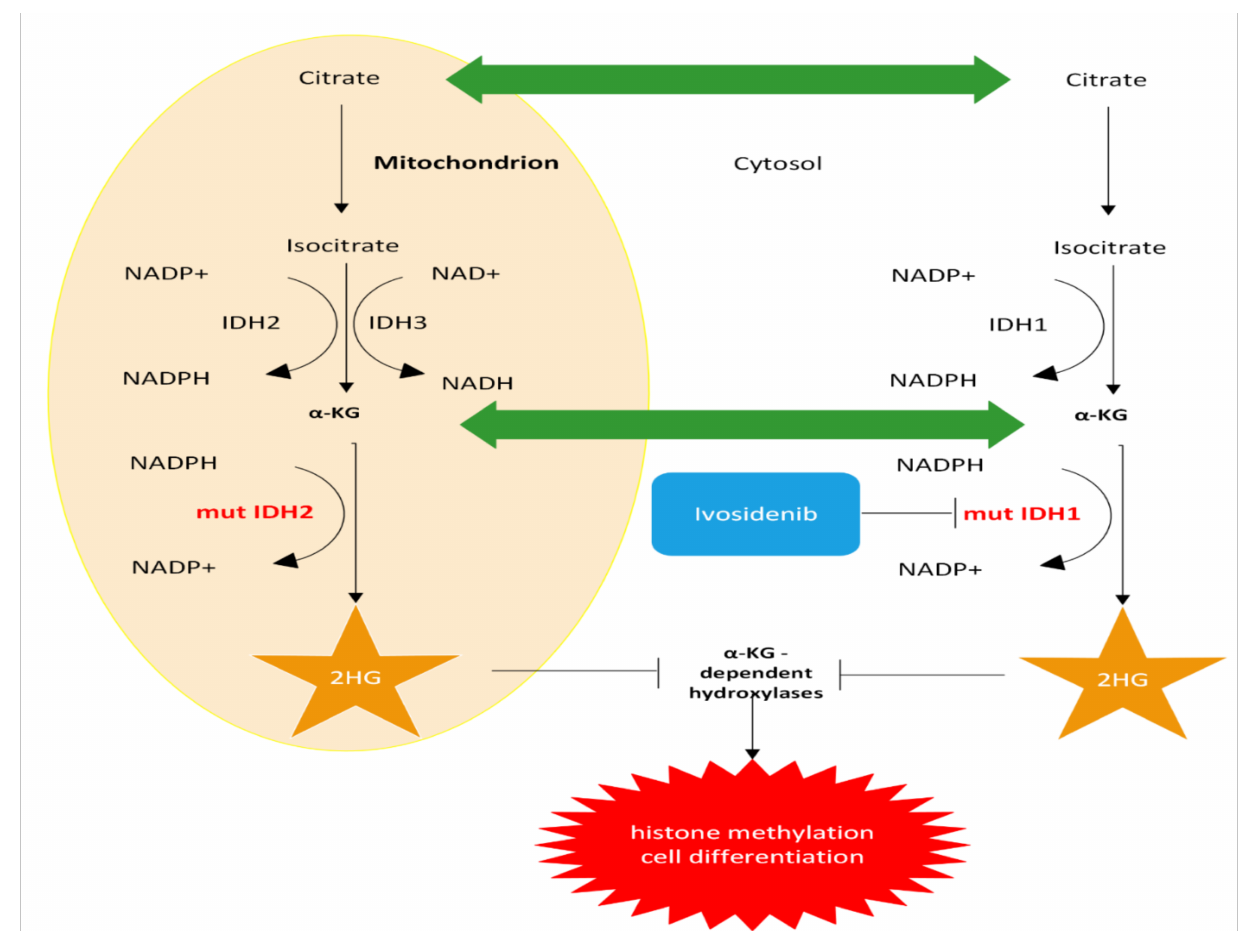
Figure 2. Targeting mutated (mut) isocitrate dehydrogenase ( IDH ) 1 and 2 in iCCA. α -KG: alpha- ketoglutarate; 2HG: